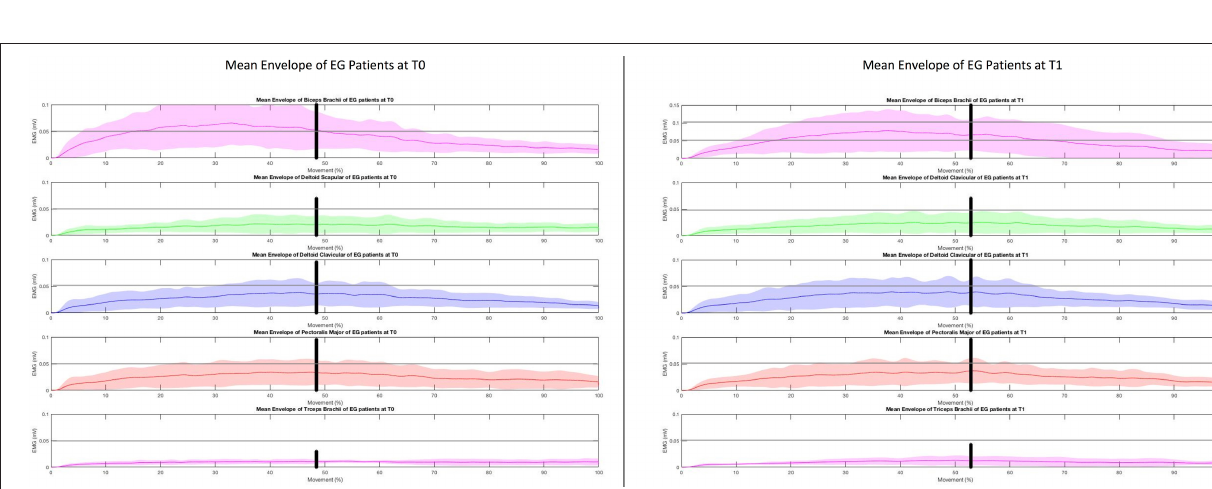
FIGURE 3 | EMGs muscle activity during the “hand-to-mouth” task in healthy controls.